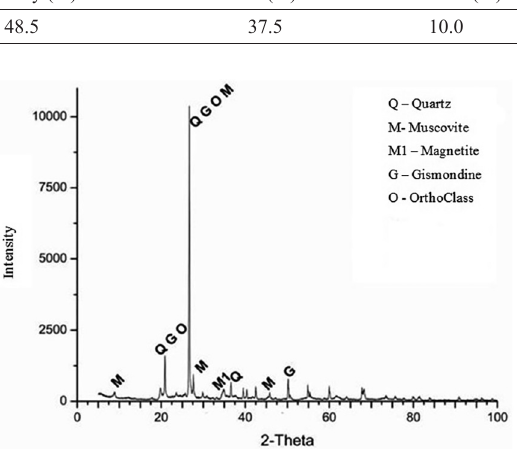
Table 2: Particle size analysis of clay Clay (%)